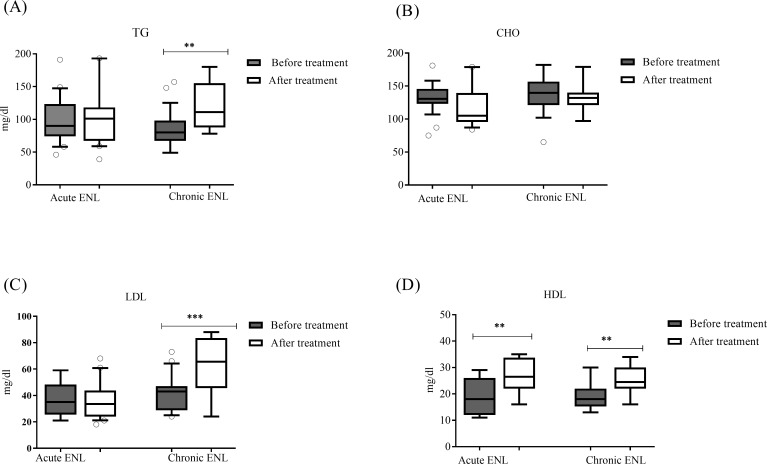
Lipid profiles before and after prednisolone treatment of acute and chronic ENL patients before and after prednisolone treatment.(A): Triglycerides; (B): Total cholesterol; (C): low-density lipoprotein; (D): High-density lipoprotein; Number of ENL = LL = 30; Statistical test: unpaired t- test. ** P<0.005; ***P<0.001. Box and whiskers show median ± interquartile range. TG = Triglycerides, TC = total cholesterol, LDL = low density lipoprotein, HDL = high density lipoproteins.